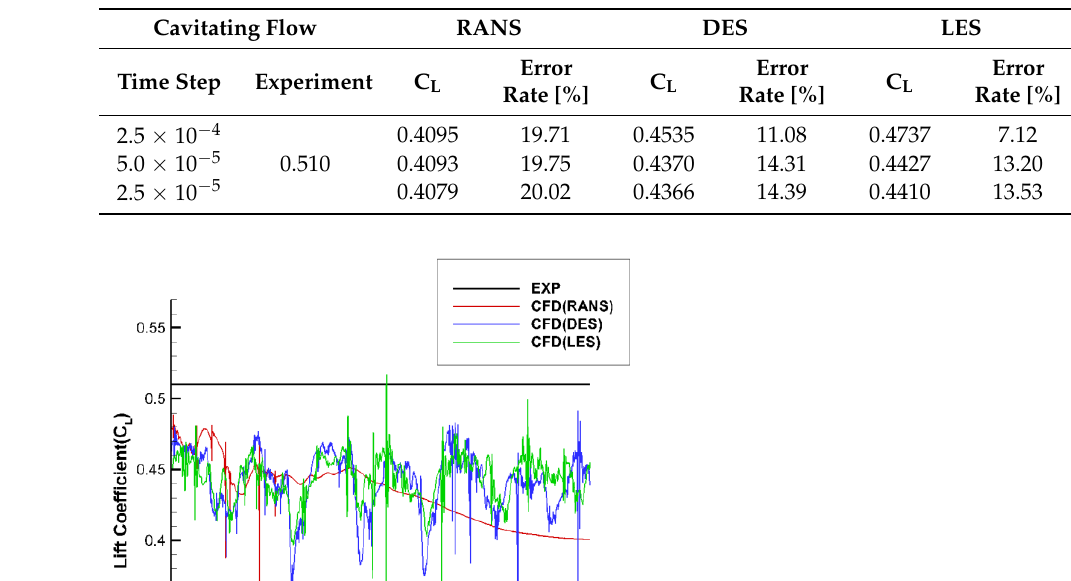
Table 4. Time-averaged lift coefficient in cavitating flow according to the time steps and turbulence models (RANS, DES, LES).